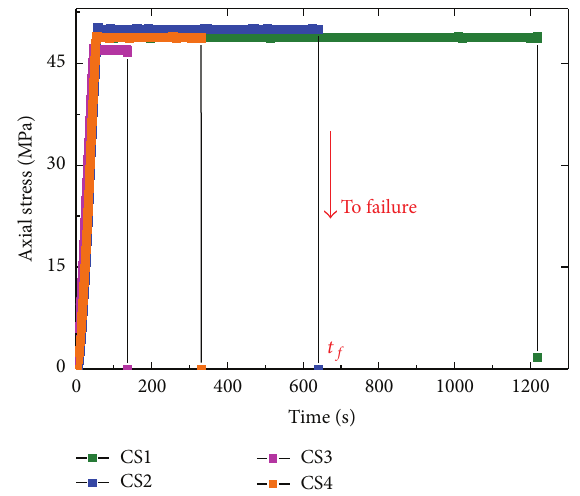
Figure 4: Axial stress versus time curves of four concrete samples (labeled as CS1, CS2, CS3, and CS4) during the total loading process, including the initial loading phases and the following creep phases.